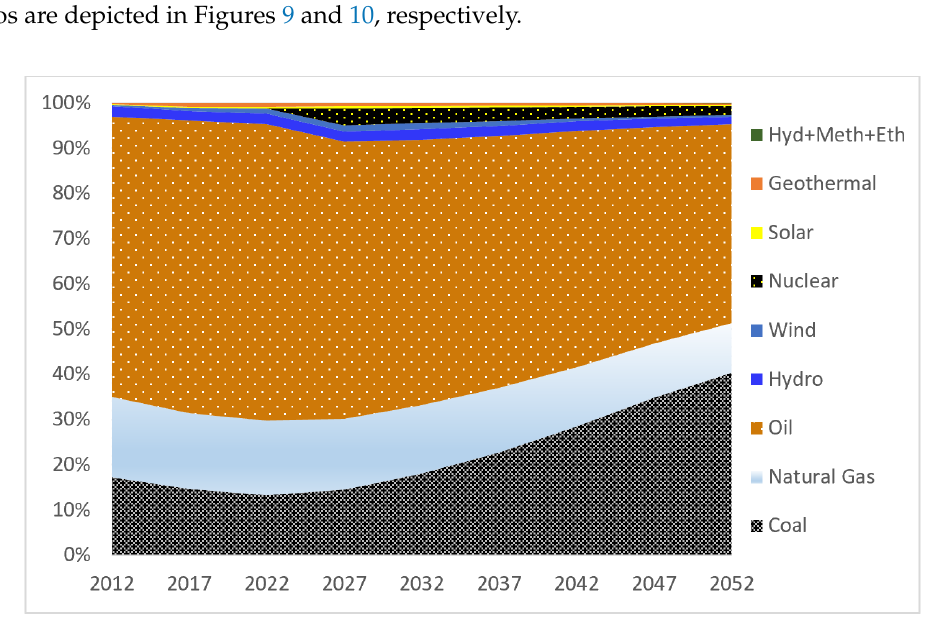
Figure 9. Primary energy supply mix in the BASE